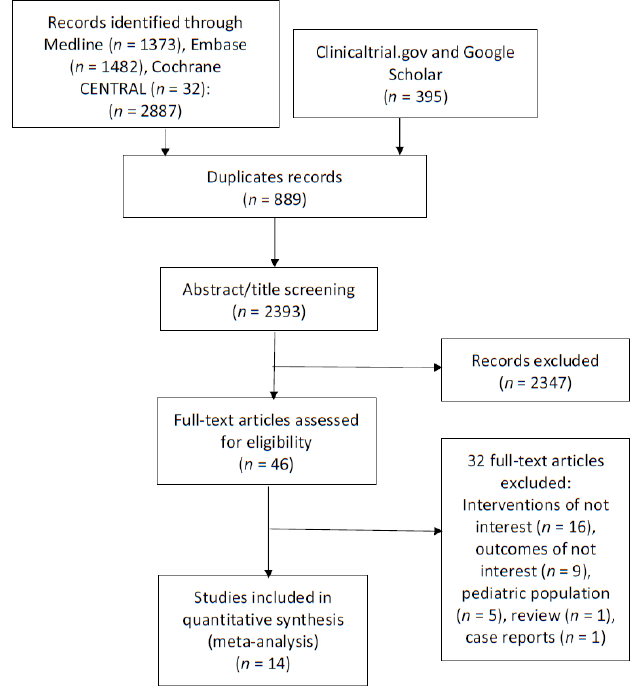
Figure 1. PRISMA flow diagram.